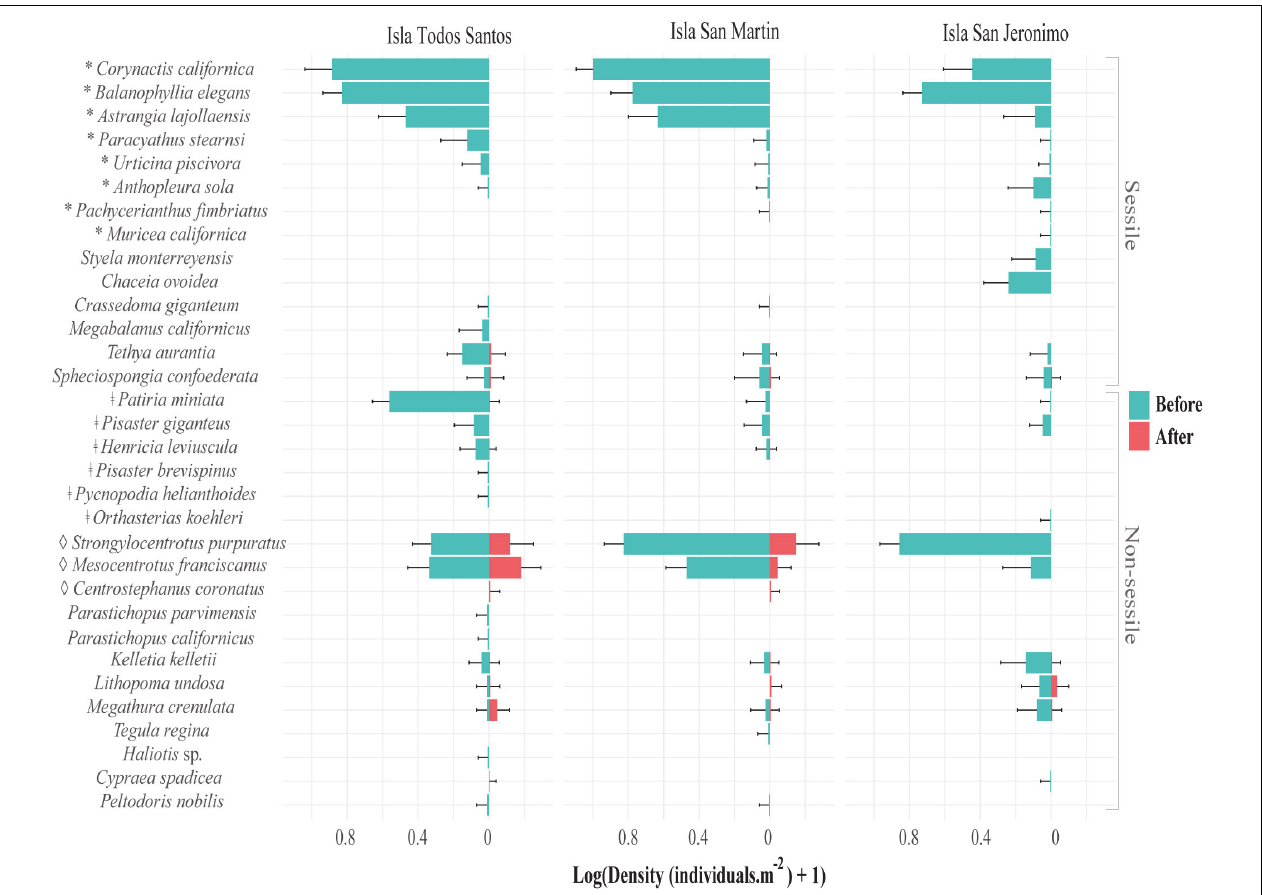
FIGURE 7 | Density of invertebrate species (mean number of individuals.m − 2 , n = two sites with three video transects, ± 95% confidence intervals) from before to after the 2014–2016 MHWs at Isla Todos Santos, Isla San Martin, and Isla San Jeronimo, in Baja California, Mexico. ∗ Represents cnidaria species, ‡ sea star species, and ♦ sea urchin